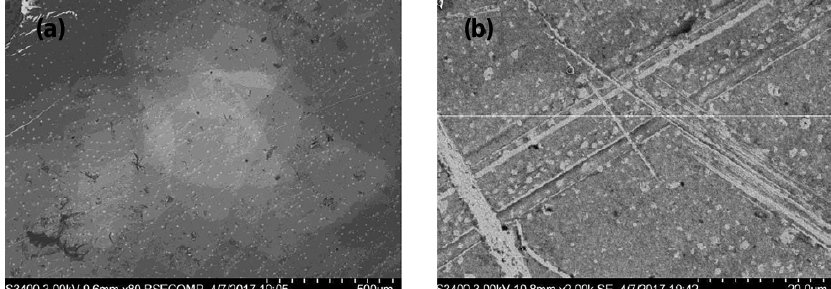
Fig. 8. SEM images of transferred ODA monolayers containing nanoparticles: a – iron HCF, b – cobalt